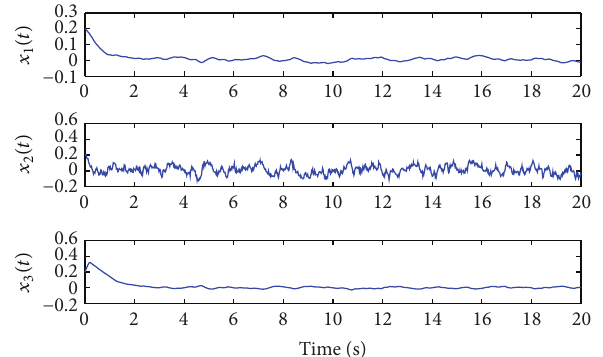
Figure 4: Time responses of states of the controlled nonlinear system under effects of disturbances.